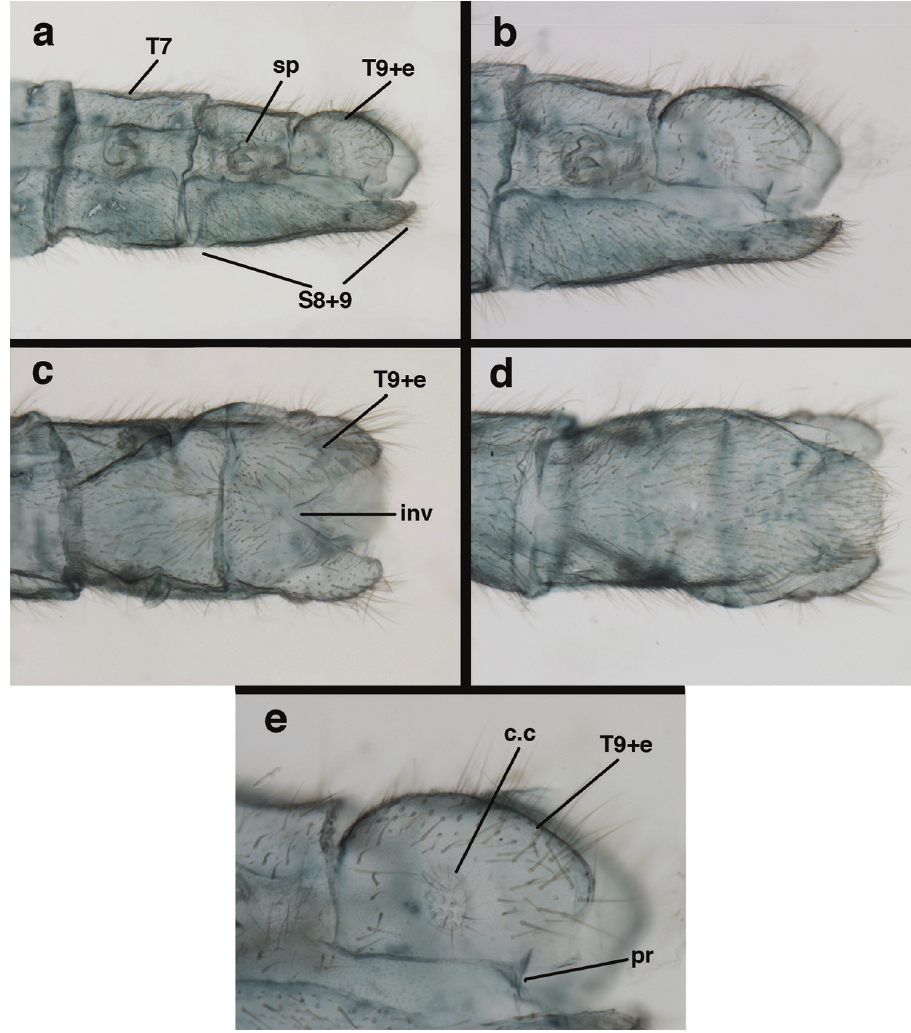
Figure 75. Ungla pennyi Tauber, sp. n. Male abdomen, ( a ) segments A7-terminus, lateral ( b ) segments A8-terminus, lateral ( c ) segments A8, T9+ectoproct, dorsal ( d ) sternite 8+9, ventral ( e ) T9+ectoproct, lateral. c.c. callus cerci inv invaginated dorsal cleft in T9+ectoproct pr triangular process sp spiracle S8+9 fused eighth and ninth sternites T7 seventh tergite T9+e ninth tergite + ectoproct (Costa Rica, Cartago, holotype,